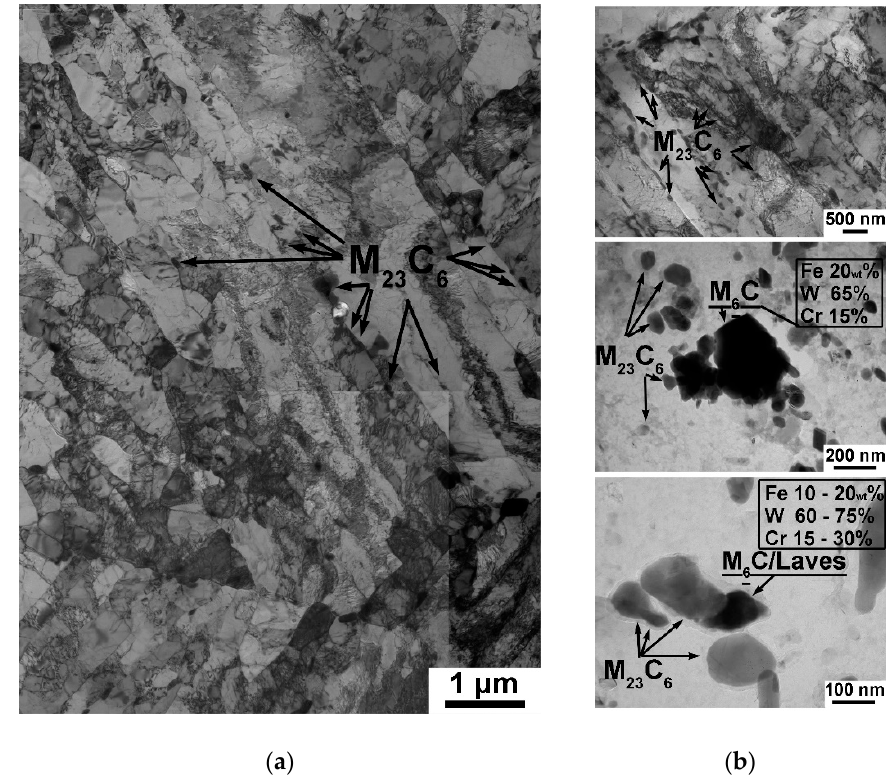
Figure 1. ( a ) The typical tempered martensite lath structure in the 9Cr2W0.005B steel; ( b ) the features of the lath structure related to increasing the B, (W+Mo) and Cr contents such as the formation of dense chains of M 23 C 6 carbides along the